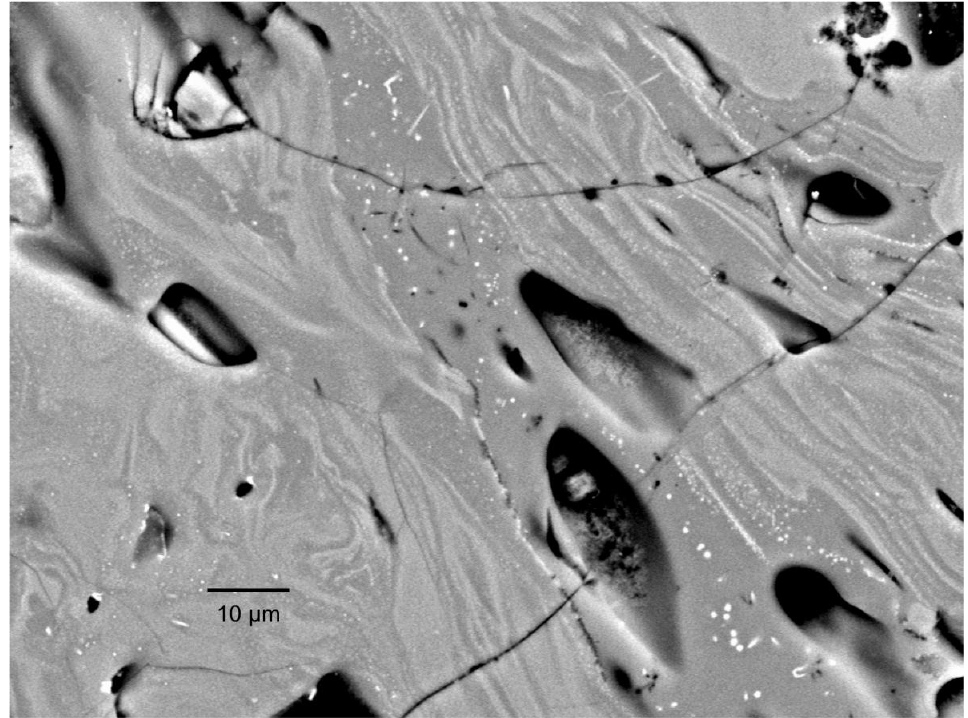
Figure 6. Scanning electron microscope backscatter image of glass in the thin section of ). Differences in shade represent differences Papagayo sample 020702-4a (65.8 wt % SiO 2 in glass composition. Notice several bright spots that occur in the darker areas. These may be microphenocrysts, although they are not observed using transmitted or reflected light